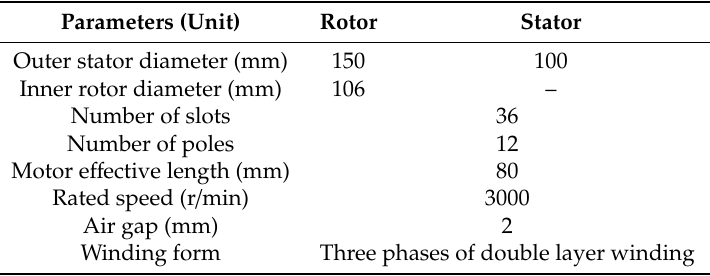
Table 1. Part parameters of spindle motor.